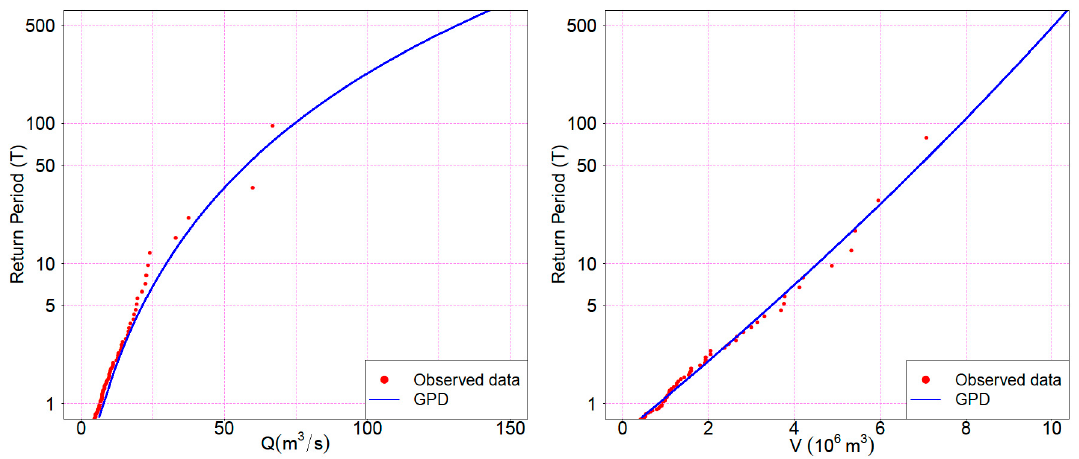
Figure 8. Empirical CDFs and GPD with PWM parameter estimation. Winter season.